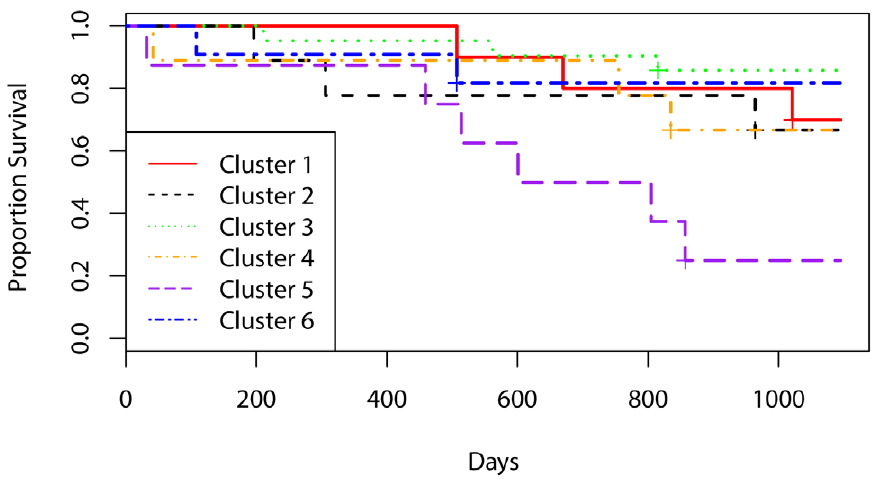
Figure 2. Kaplan-Meier survival curves depicting three year survival for each of the six clusters identified via unsupervised hierarchical cluster analysis.